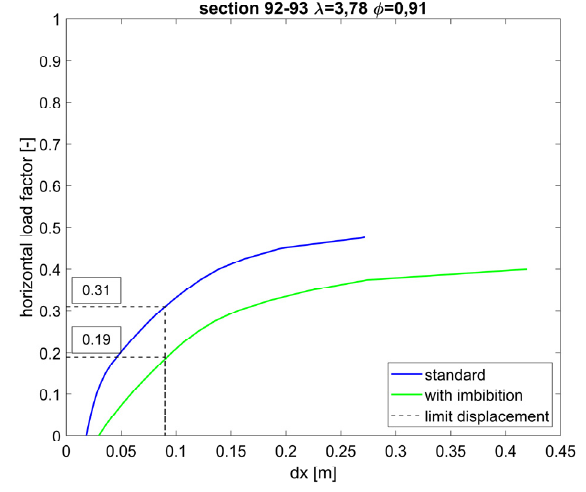
Figure 8. Push over curves for the examined sections.